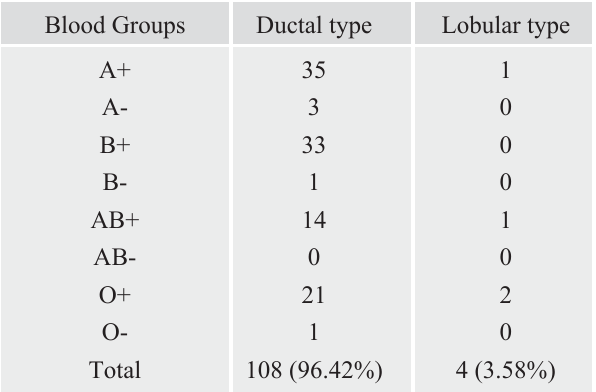
Blood groups and histological types of breast cancer